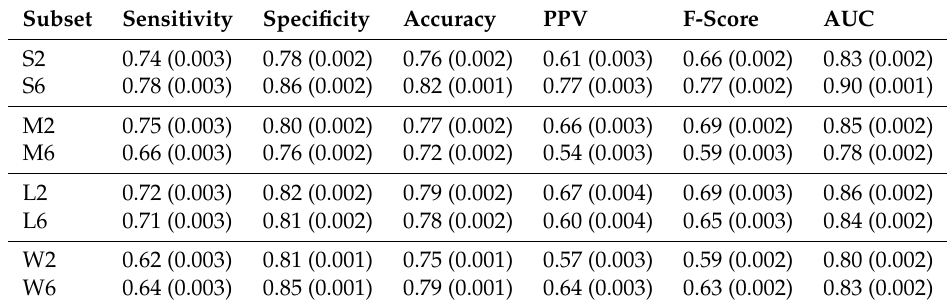
Table A8. Predictive performance of naïve Bayes based on the estimated sensitivity, specificity, accuracy, positive predictive value (PPV), F-score and the area under receiver operating characteristic curve (AUC) for two-week and six-week restriction period among the cows in early (S), mid (M) and late (L) lactation stage using cross validation